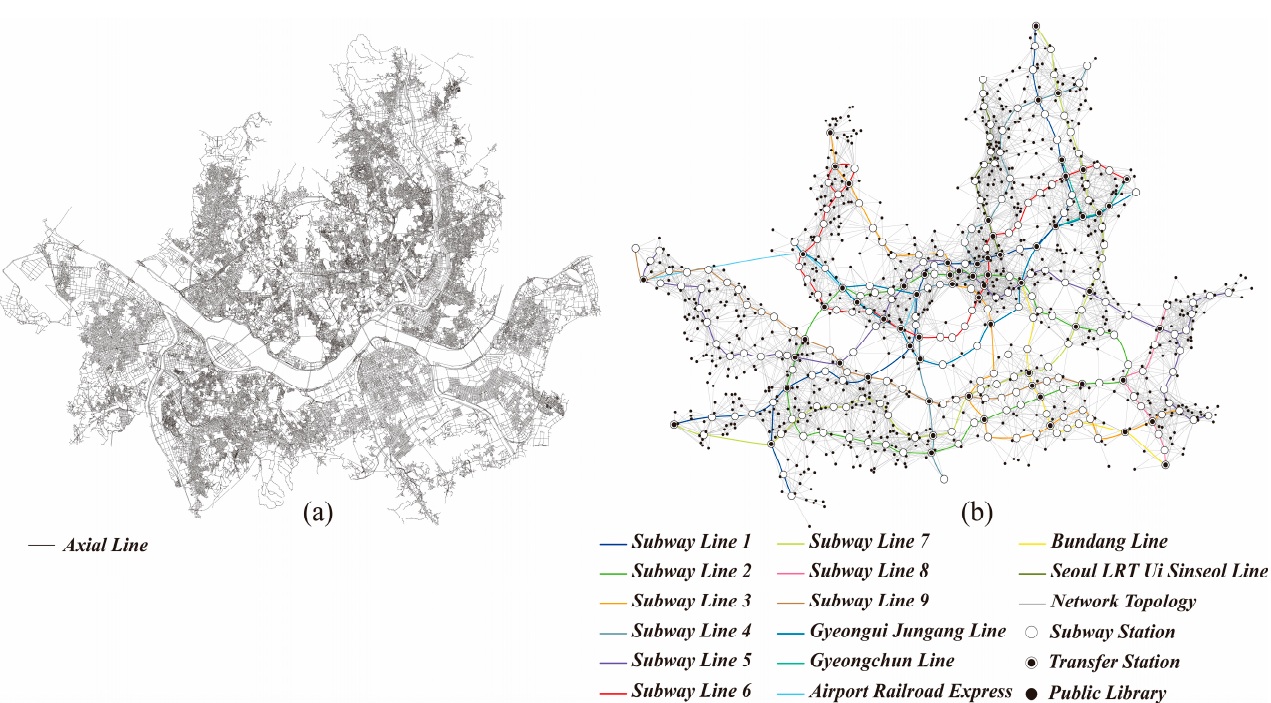
Figure 4. Spatial analysis for calculating public library accessibility indicators: ( a ) an axial map of Seoul; ( b ) a convex space topological connection structure of public libraries along the subway lines.